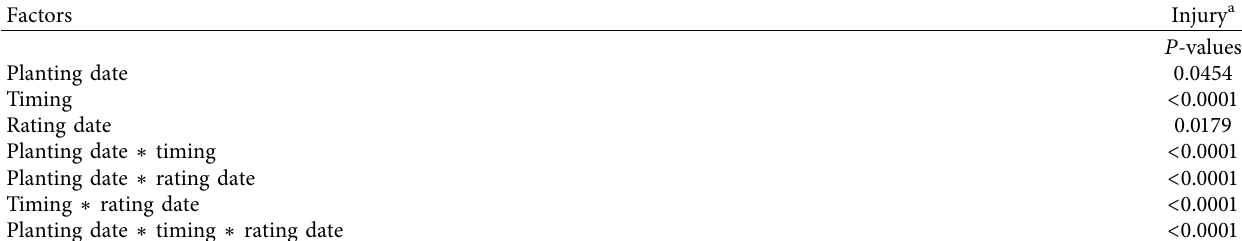
Figure 5: (a) Image of Cercospora leaf blight ( Cercospora kikuchii ) on a soybean plot treated with dicamba at the V 3 application timing versus (b) a plot treated with dicamba applied at the R 1 application timing. Images taken while soybean were in the R 6 growth stage. Table 3: Effects of planting date, application timing, and rating date to injury analyzed as a repeated measures analysis for the planting date experiment conducted in Fayetteville and Stuttgart, AR, in 2019.